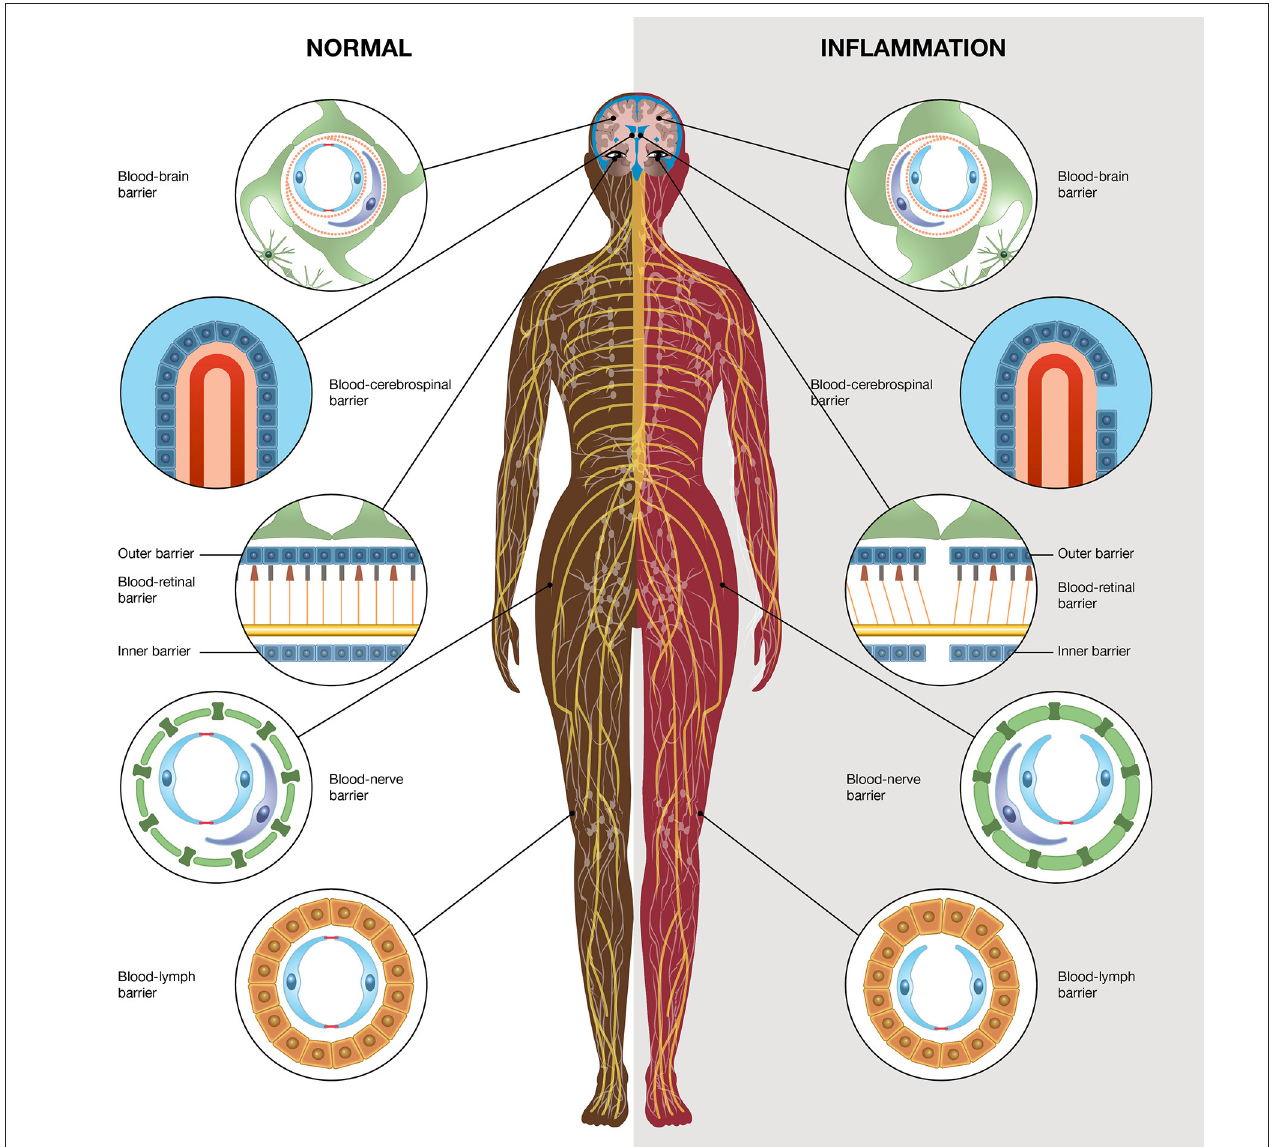
FIGURE 1 | Schematic illustration high-lightening different barriers in the body; the blood-brain barrier, blood-retinal barrier, blood-nerve barrier, blood-lymph barrier, and blood-cerebrospinal fluid barrier. The left side demonstrates the normal physiological conditions and the right side demonstrates inflammatory conditions. The illustration is made by Pontus Andersson, ArtProduction, Gothenburg,